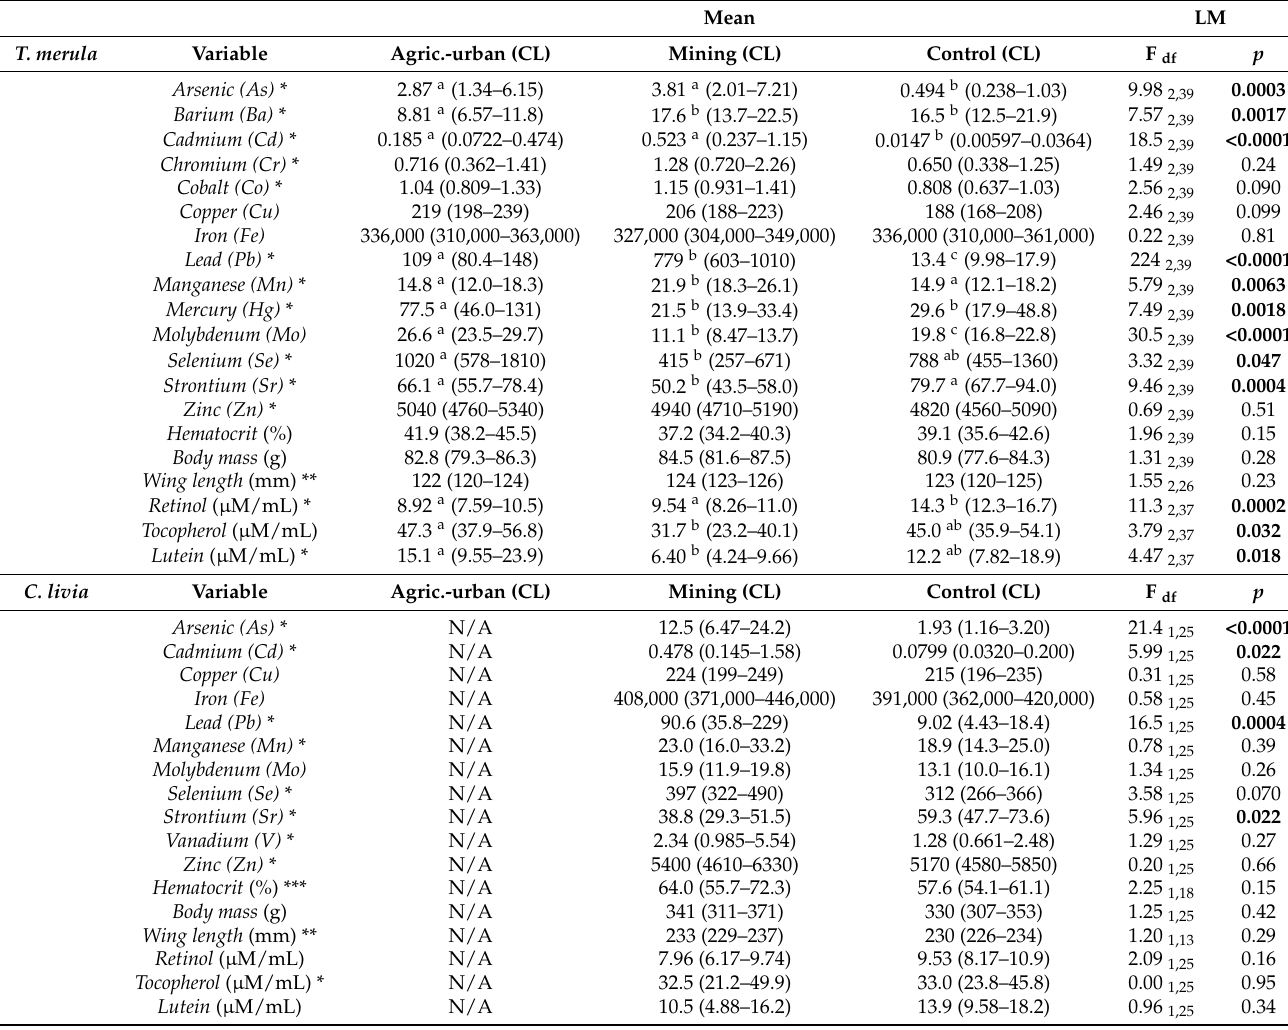
Table 2. Mean ( ± 95% confidence limits) concentrations (ng/mL, w.w.) of the elements in the blood, hematocrit, body measurements, and plasma biochemistry of the Eurasian blackbird ( Turdus merula ; n = 42) and wild rock pigeon ( Columba livia; n = 27) in the agricultural–urban area, mining area, and control area. Linear models (LM) for comparison of means. Tukey’s test: means with the same letter are not statistically